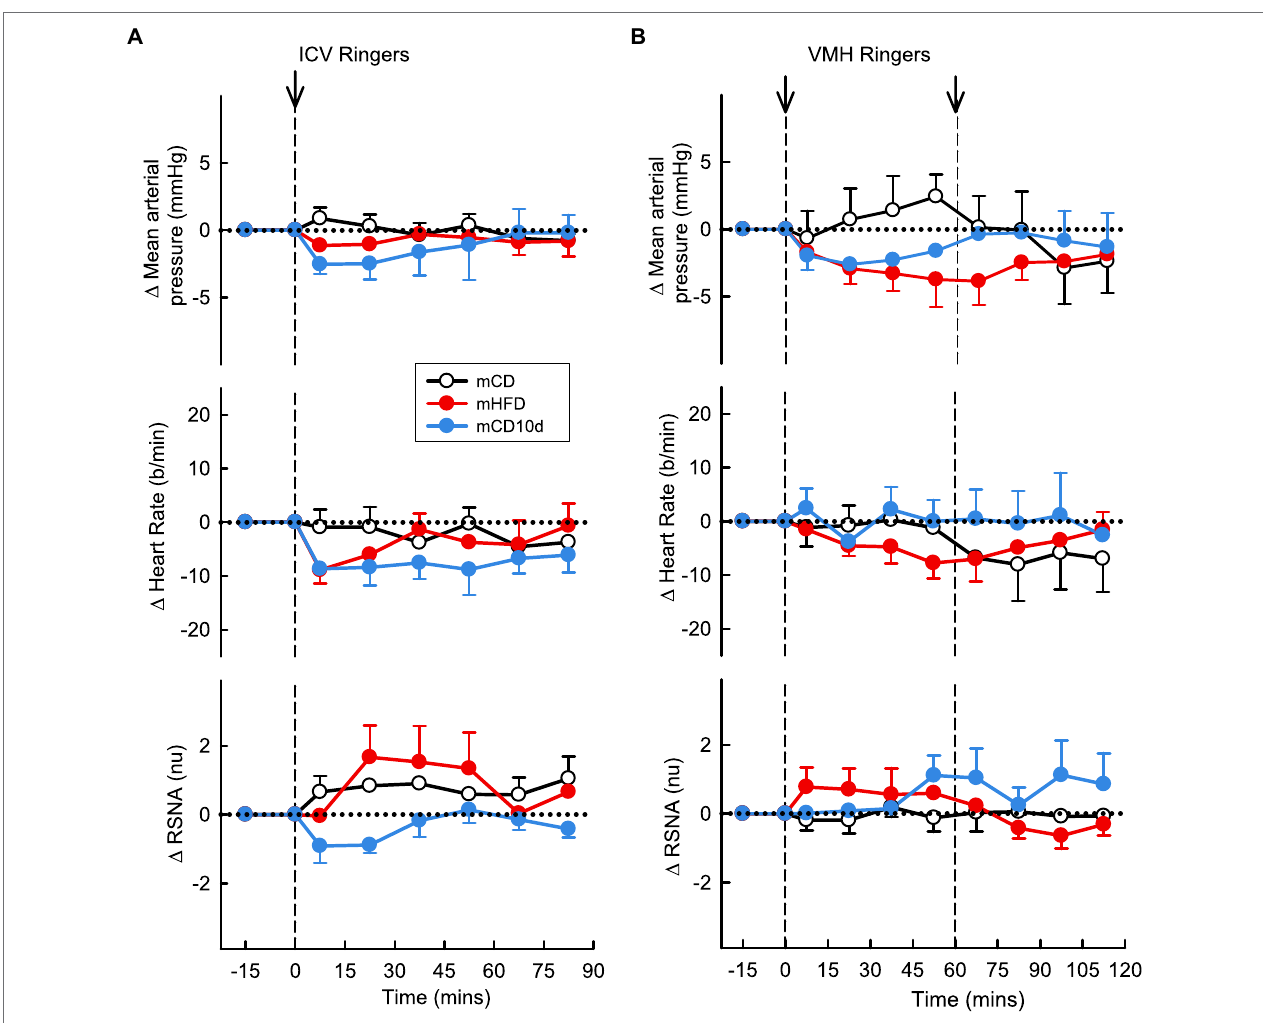
FIGURE 12 | Effects of Ringer’s solution injected ICV and into the VMH. Average changes in MAP, heart rate, and RSNA (normalized units) from control in each group after (A) : ICV Ringer’s (vehicle) and (B) : VMH administration of Ringer’s (vehicle) in mCD [white, (A) n = 9, (B) n = 5], mHFD [red, (A) n = 8, (B) n = 9], and mCD10d [blue, (A) n = 8, (B) n = 7] rabbits. Data are mean difference ±